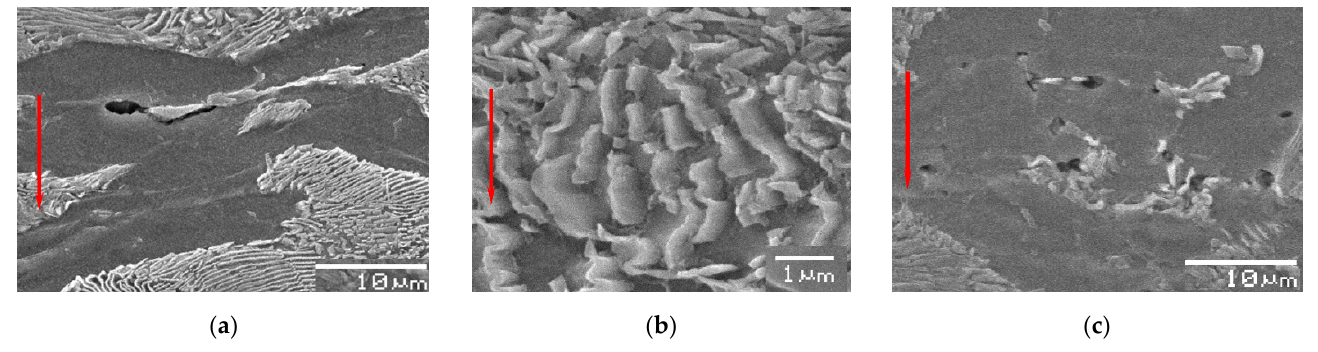
Figure 9. Microstructural damage for strain level ε z3 = 1.1: ( a ) development of a microcrack in the ferrite base; ( b ) fracture of cementite lamellae; ( c ) microdamages caused by decohesion at the ferrite/ferrite or ferrite/pearlite boundary surfaces (red arrow—direction of upsetting).